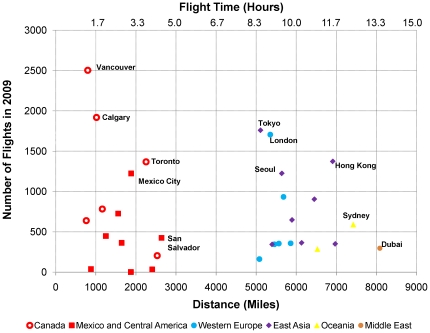
2009 Mean Flight Times to the San Francisco International Airport (SFO).Source: Analysis of T-100 International Segment data, Bureau of Transportation Statistics, U.S. Department of Transportation.